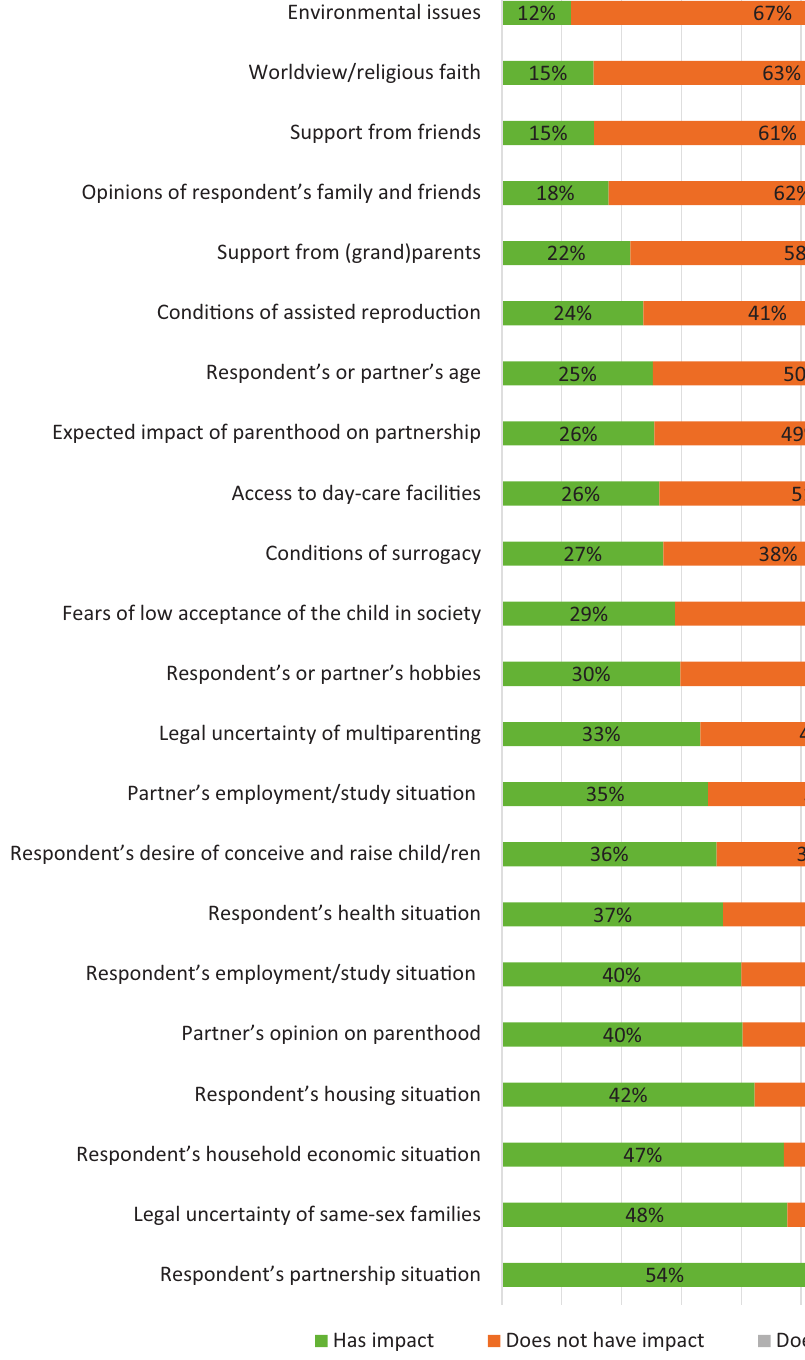
Figure 4. Factors in the view of gay men that have affected their parenting